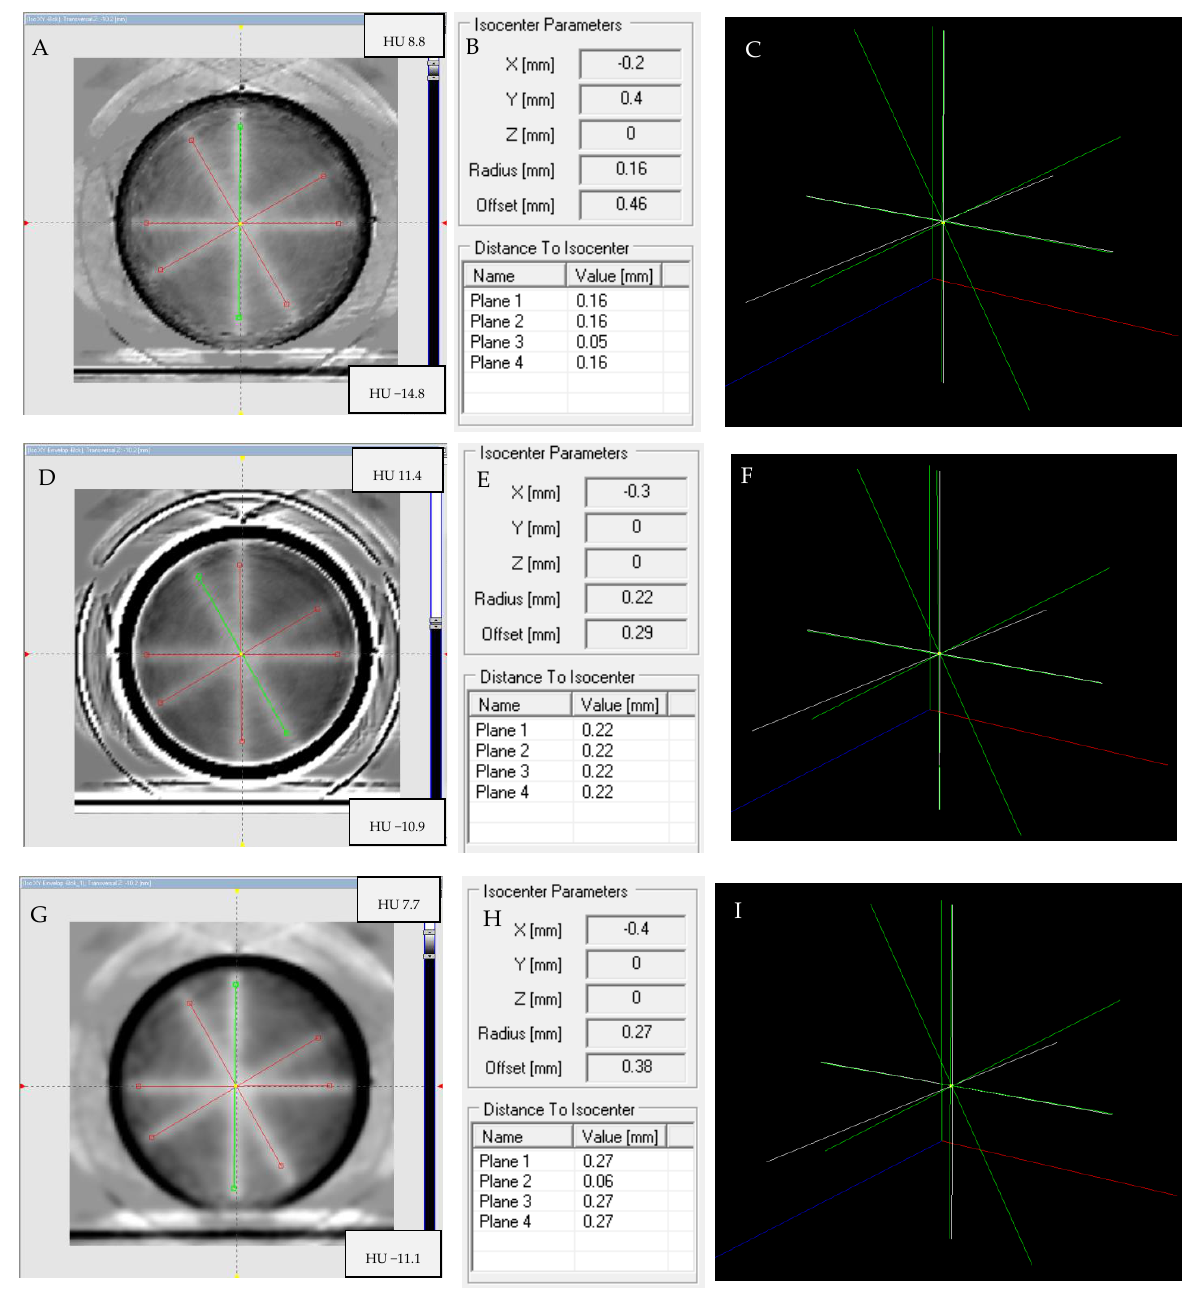
Figure 8. Isocenter determination. Processing of iCBCT images of PABIG nx in PH-5-DD1 GeVero Co. container irradiated with the TrueBeam accelerator (mode: Pelvis): ( A ) is for the mean series (calculated from three series) with the mean background (calculated also from three series) subtracted; ( B ) corresponds to the isocenter results of ( A ), and ( C ) is for the 3D visualization of the isocenter determined in ( A ); ( D ) is for the mean series (calculated from three series) filtered with the Envelope filter (mean, 3 iterations, Kernel = 3, Kernel mode = 2D, Kernel unit = pixels) with the mean back- ground subtracted (calculated from three series); ( E ) corresponds to the isocenter results, and ( F ) is for the 3D visualization of the isocenter determined in ( D ); ( G ) is like ( D ), however, the background was also filtered with the Envelope filter (same parameters); ( H ) is for the isocenter results for ( G ), and ( I ) is the 3D visualization of the isocenter determined in ( G ). The colored lines in ( A , D , G ) intersect at the isocenter. The isocenter is marked with a yellow dot.